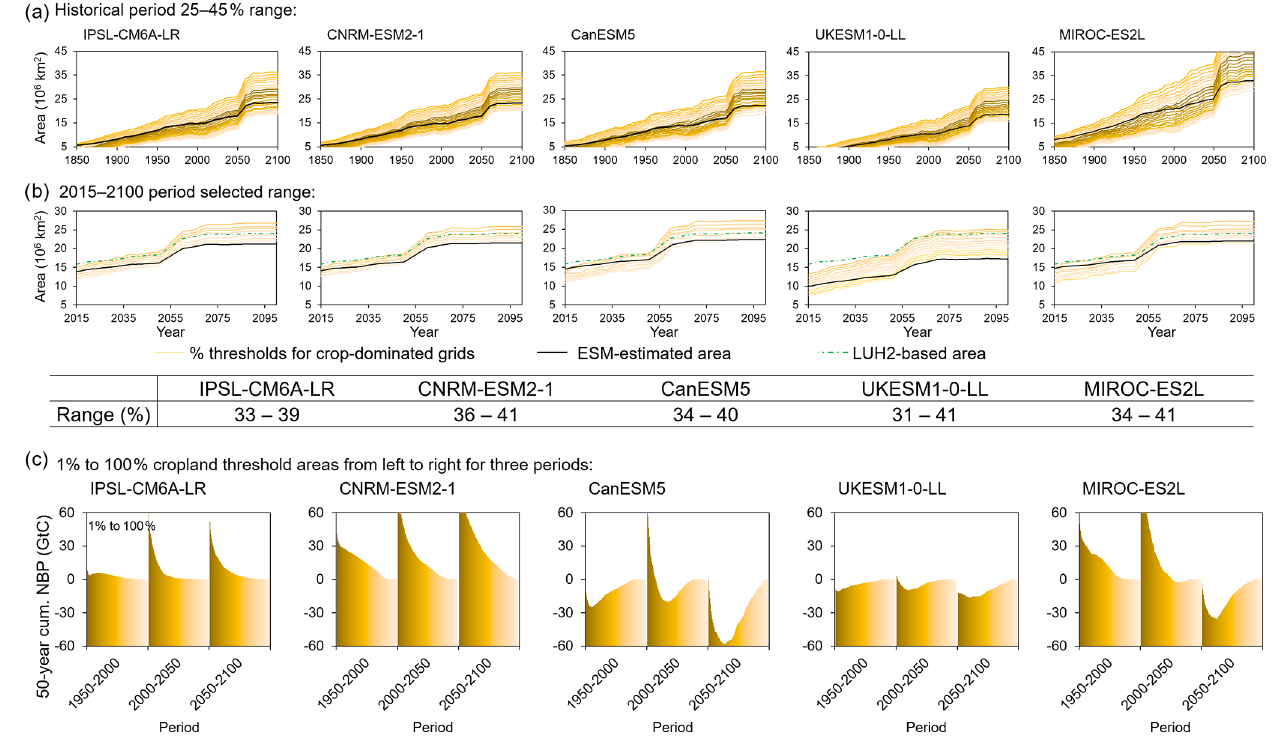
Figure A2. (a) The cropland-fraction thresholds ranging from 25% to 45% of the grid box area analyzed in the sensitivity study and (b) the selected (resultant) range of thresholds for identifying the energy-crop-concentrated area with the selected range for each ESM indicated in the table. Panel (c) shows the cumulative NBP of the areas corresponding to the range of cropland thresholds from 1% to 100% (left dark to right light color) in three